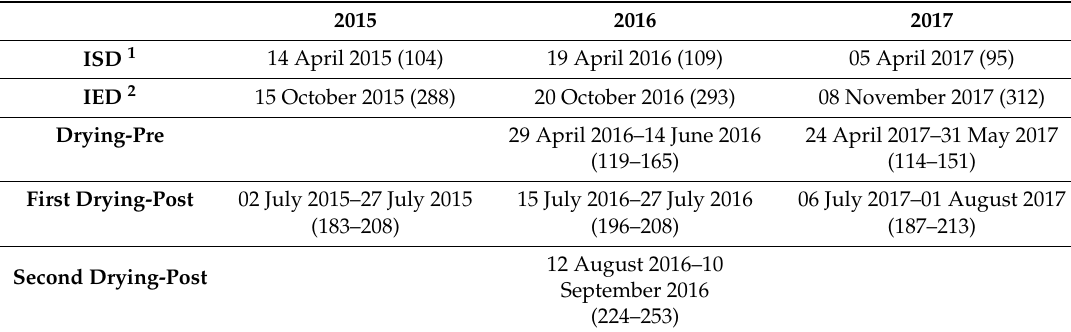
Table 1. Dates of the irrigation